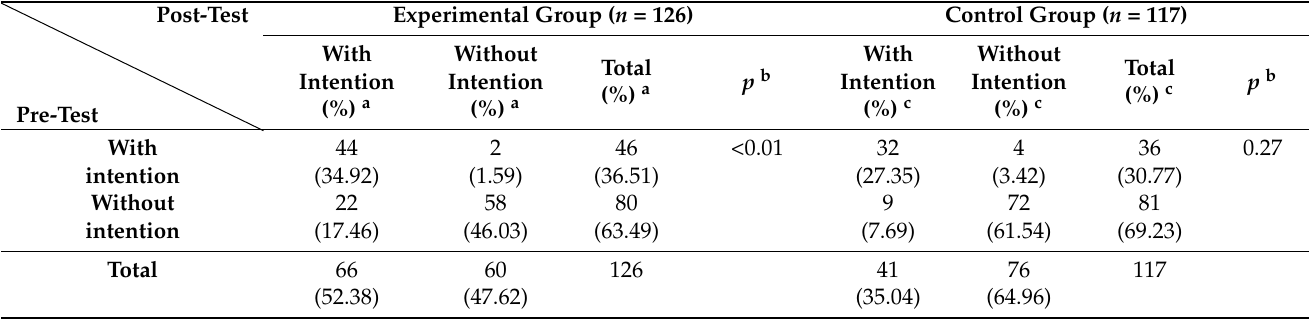
Table 2. The pre- and post-test proportions of the influenza vaccination intention within each group of